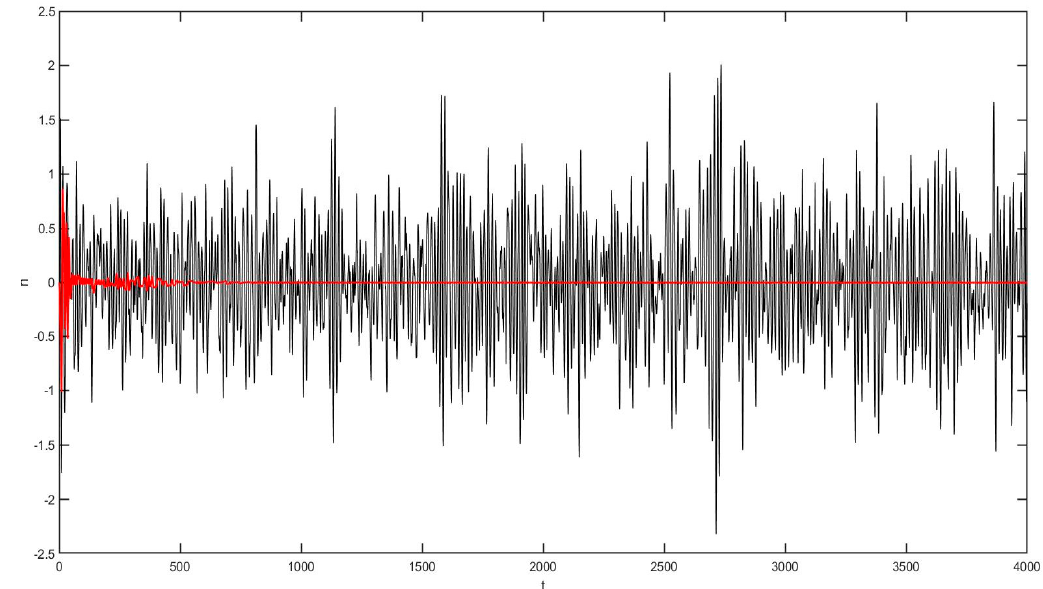
Figure 33. Effect of noise on torsional displacement with active control.